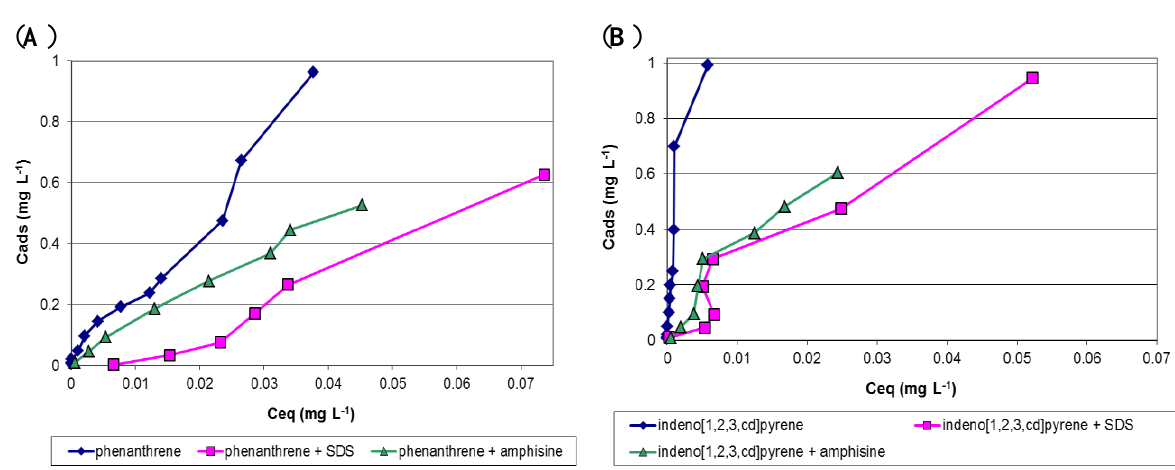
Figure 3. Adsorption isotherms of different PAHs at water/kaolin interface in the presence of SDS (8 × 10 −2 mol∙L −1 ) or amphisin (7.2 × 10 −4 mol∙L −1 ) and in their absence at 25